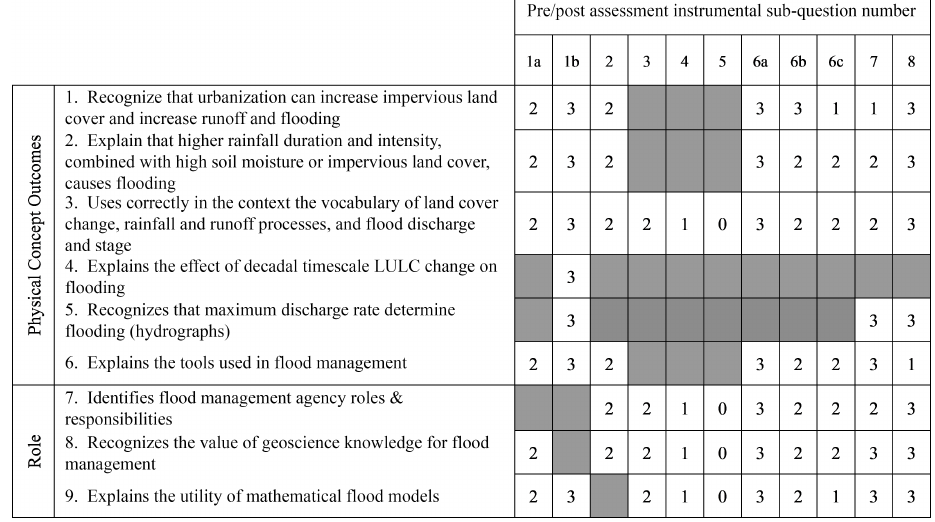
Figure 2. Example of a completed assessment matrix mapping learning outcome rubrics to instrument question responses. This example student gave relevant responses to all questions (i.e., no “0” ratings), and the matrix generally indicates an “Apprentice” level of conceptual